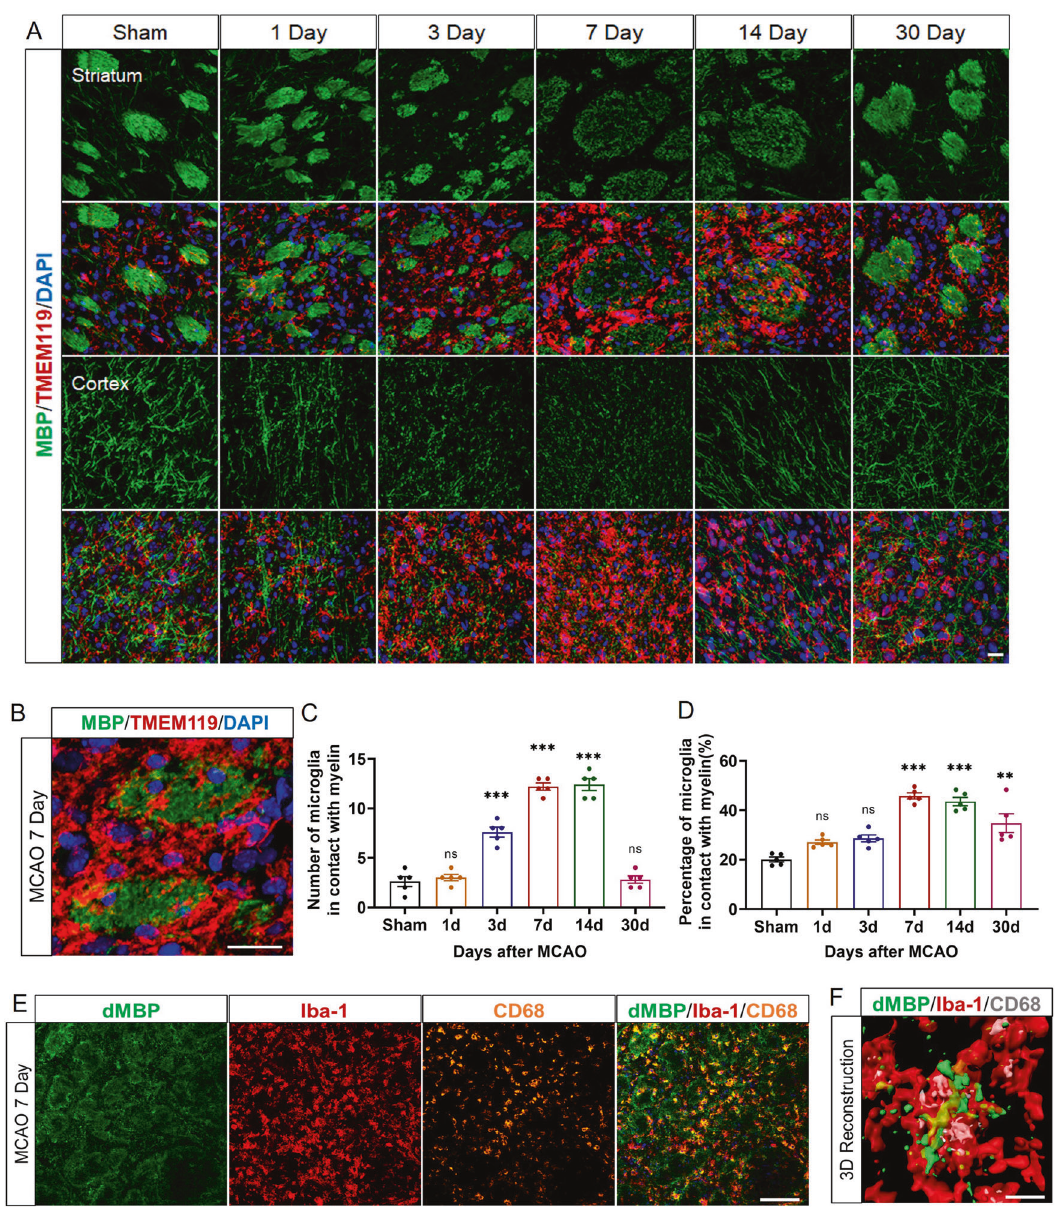
bars, 20 μ m. B Representative image of microglia centered around the damaged myelin bundles in the striatum area. Scale bar, 20 μ m. C The number per fi eld and D the percentage of microglia in contact with myelin bundles in the striatum of sham or 1st, 3rd, 7th, 14th, 30th Day after tMCAO. n = 5. ** p < 0.01, and *** p < 0.001 compared to sham group, values were shown as mean ± SEM. E Representative images of dMBP (green), Iba1 (red), and CD68 (orange) immunostaining on the 7th Day after tMCAO. Scale bar, 100 μ m. F Three-dimension reconstruction of microglia engulfed myelin debris. dMBP, green; Iba1, red; CD68, gray. Scale bar, 10 μ